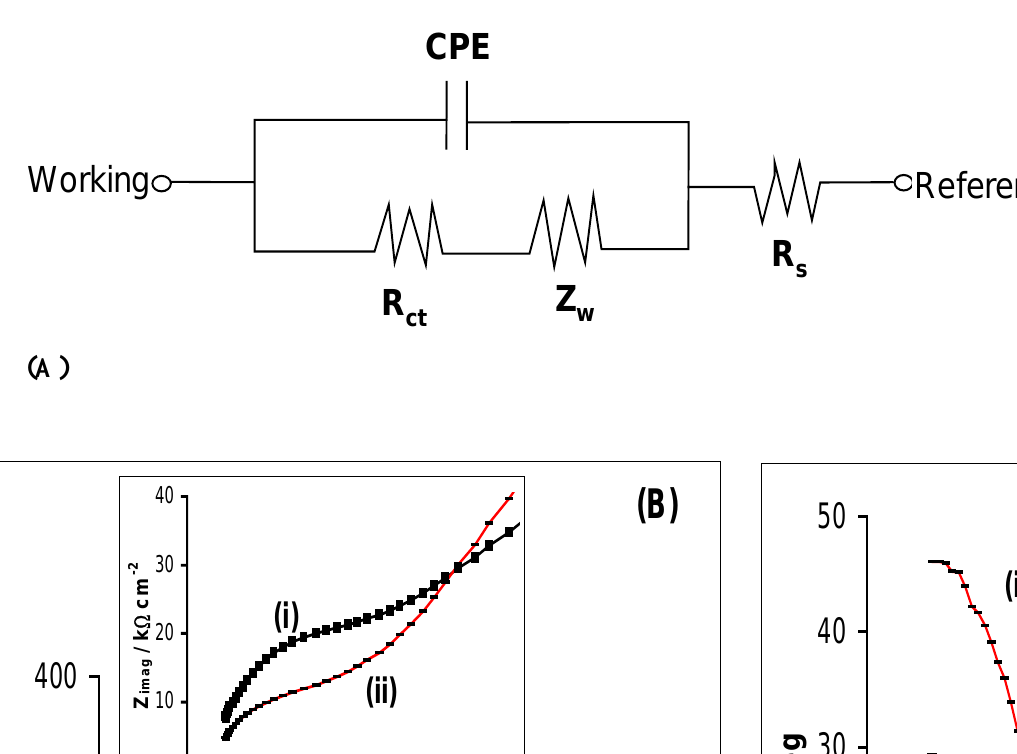
Figure 4: (A)The equivalent circuit model where R resistance, the charge transfer resistance, double layer resistance and Warburg impedance, respectively. (B) Nyquist and (C) Bode Plots of (i) GCE and (ii) GCE-CoPc-(CoTPP) KCl containing equimolar mixture of K